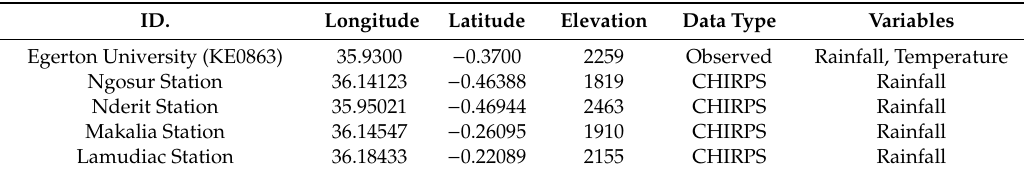
Table 1. Rainfall and temperature data used for SWAT modeling from 1981 to 2018.